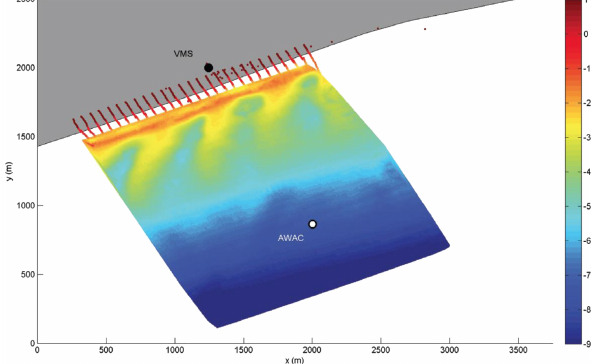
Figure 4. Bathymetry of the study area.